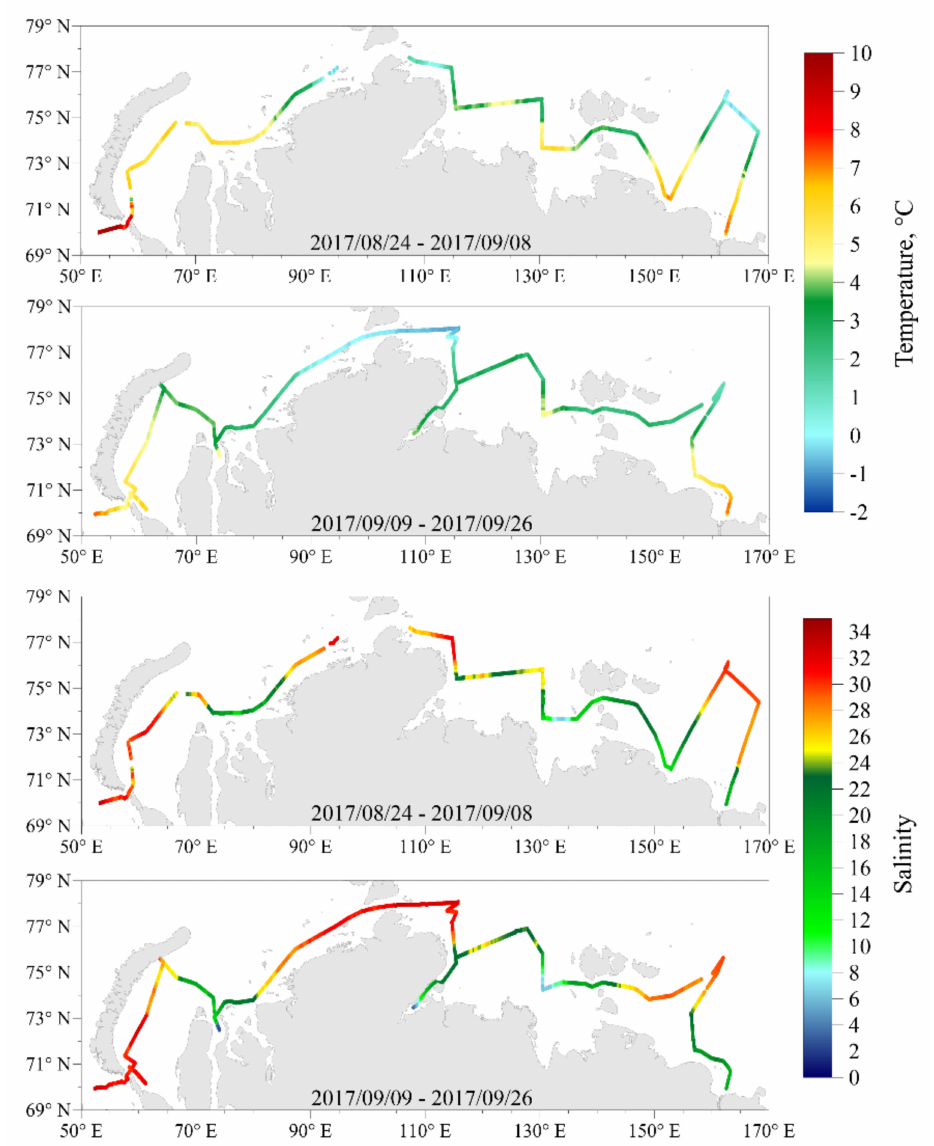
Figure 2. Water temperature and salinity at the depth of 2.7 m (thermosalinograph data) along the route of the 69th cruise of the R/V Akademik Mstislav Keldysh in the Kara, Laptev and East-Siberian